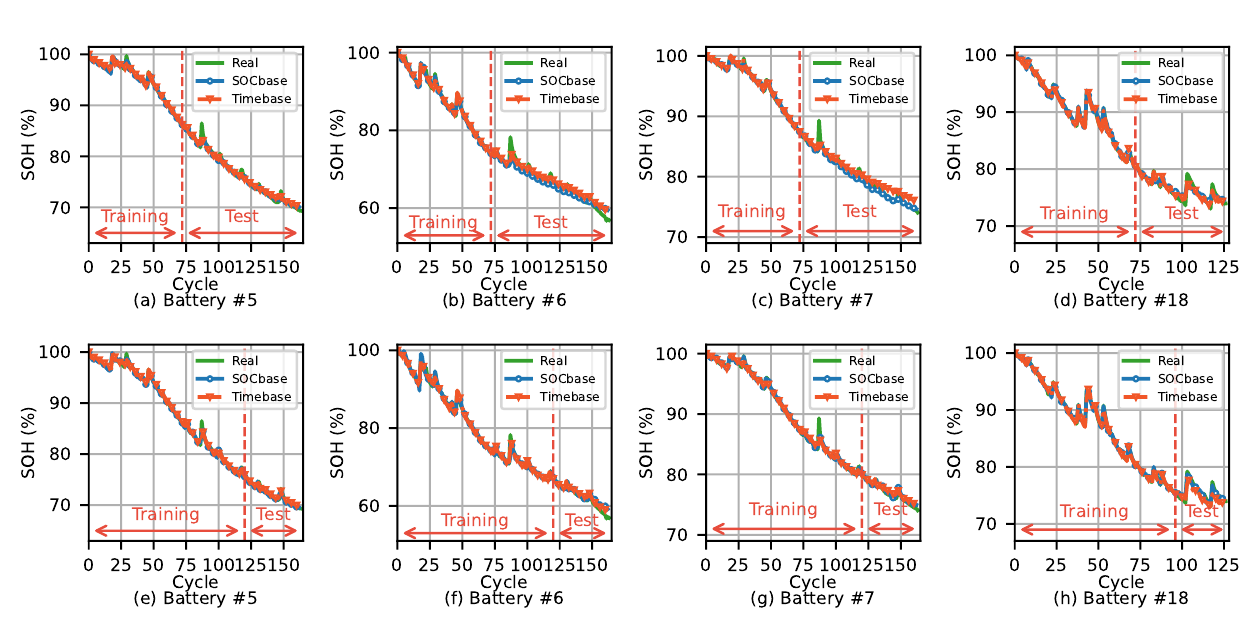
Figure 8. SOH estimation results using